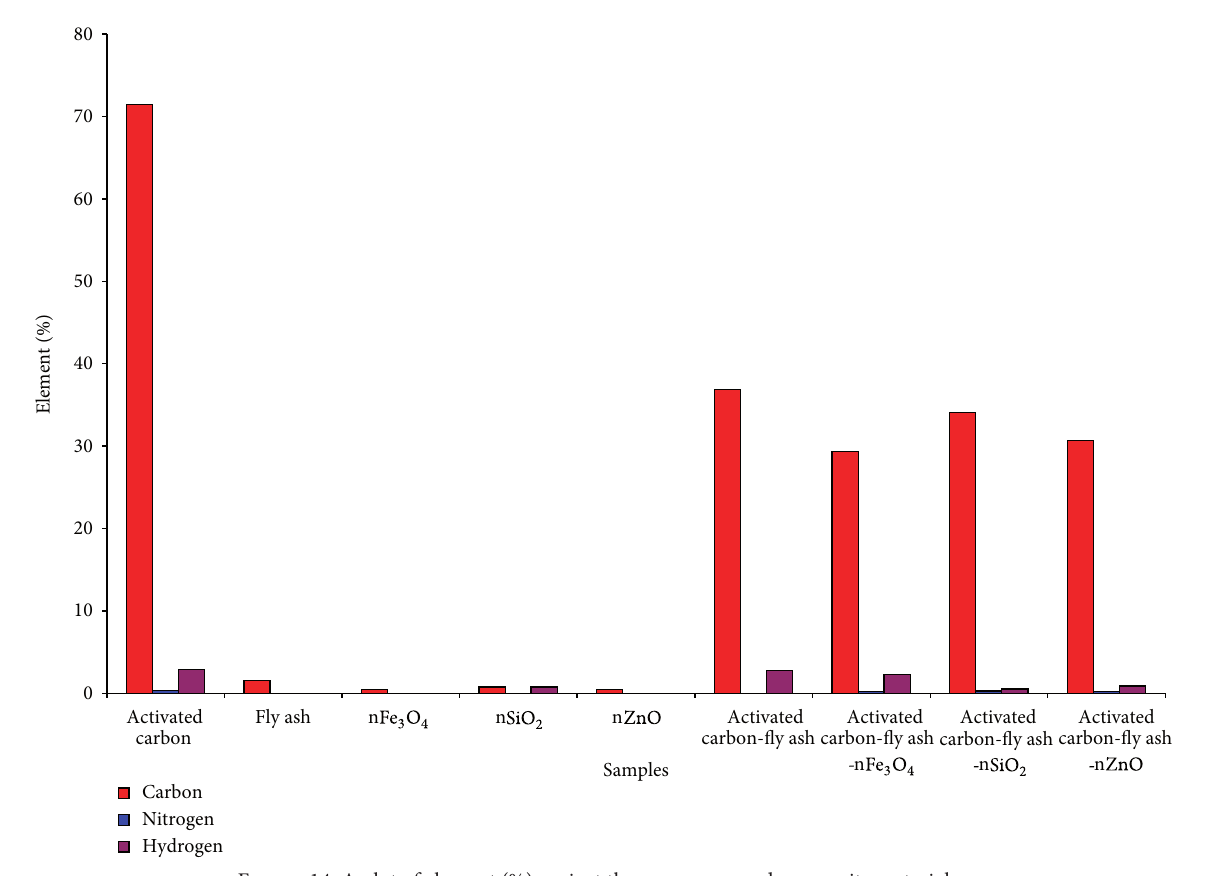
) against the precursors and composite materials. %